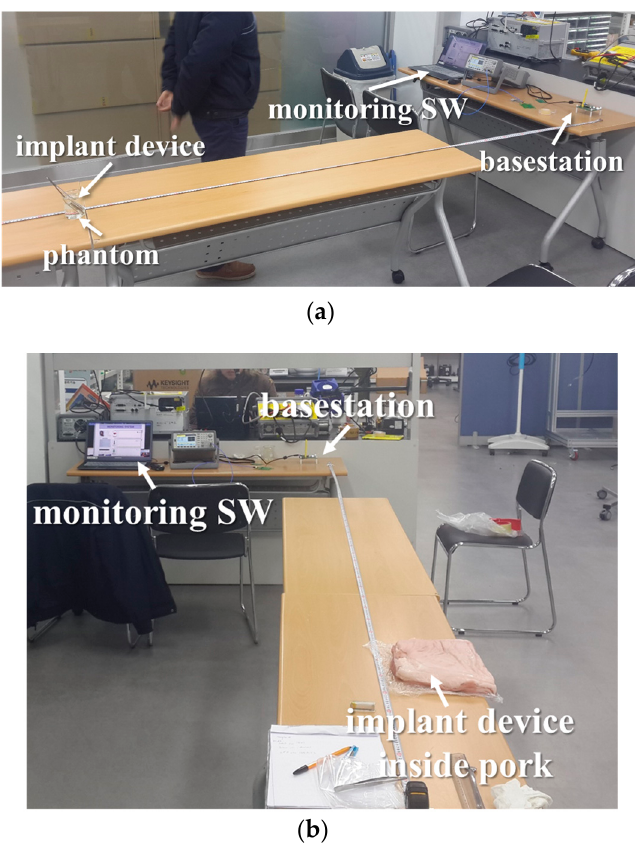
Figure 13. Experiment setup used to measure the maximum communication range when the implantable device is placed inside the ( a ) phantom and ( b ) pork.